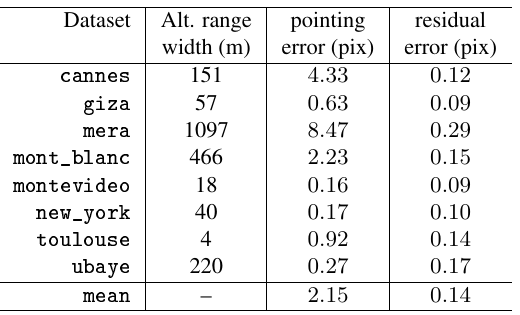
Table 1: Pointing error values before and after correction. On average the correction algorithm reduces the error by a factor